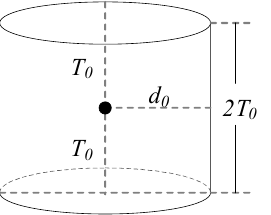
Figure 1. Space-time cylinder model for spatiotemporal density- connected